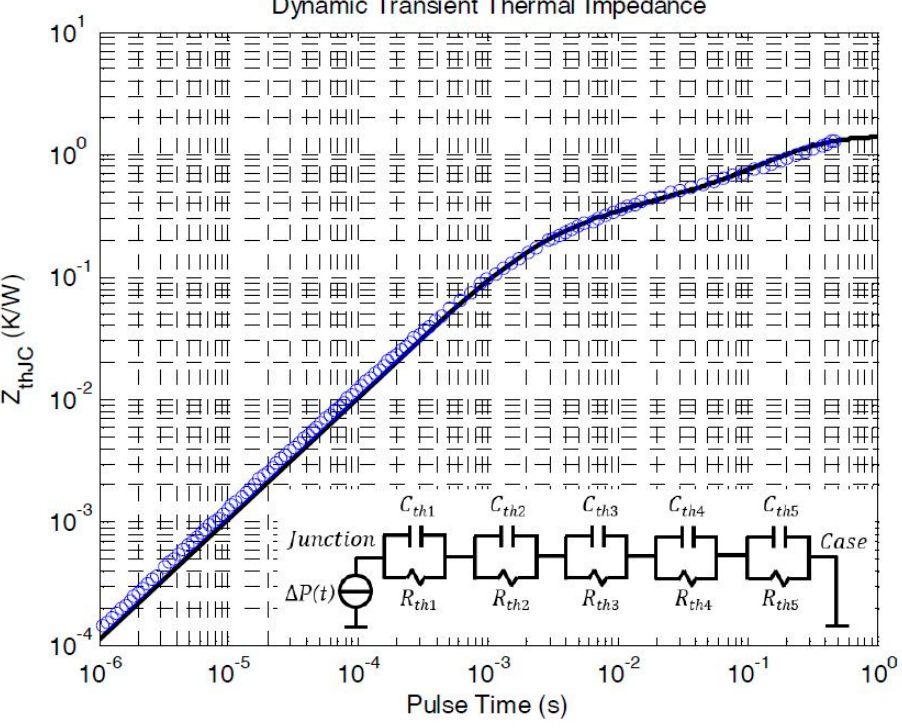
Figure A1. Dynamic thermal impedance (Z th,JC ) versus pulse width (t p ) for single pulse [14]. Table A1. The fitting parameters R th and C th for Foster RC models.